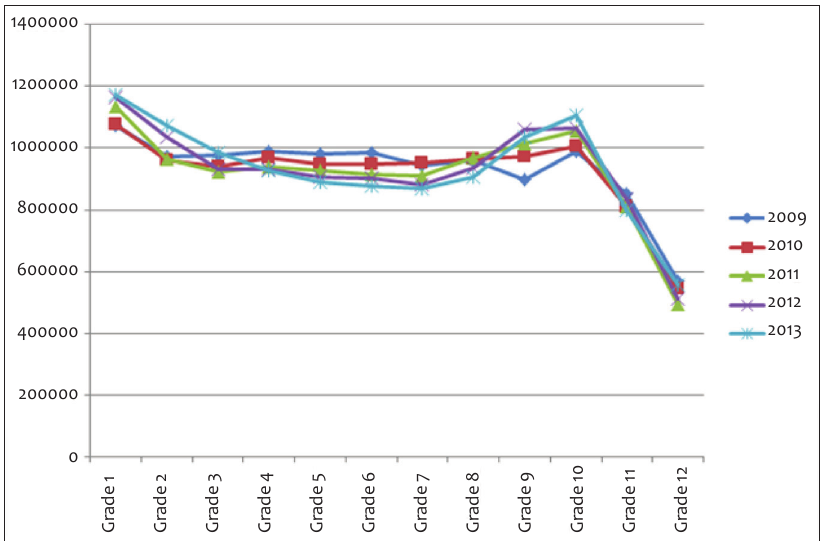
Figure 2: Enrolment in public schools by grade and year, 2009-2013 (Source: Author’s calculation, based on SNAP data, 2009-2013) Annual School Survey